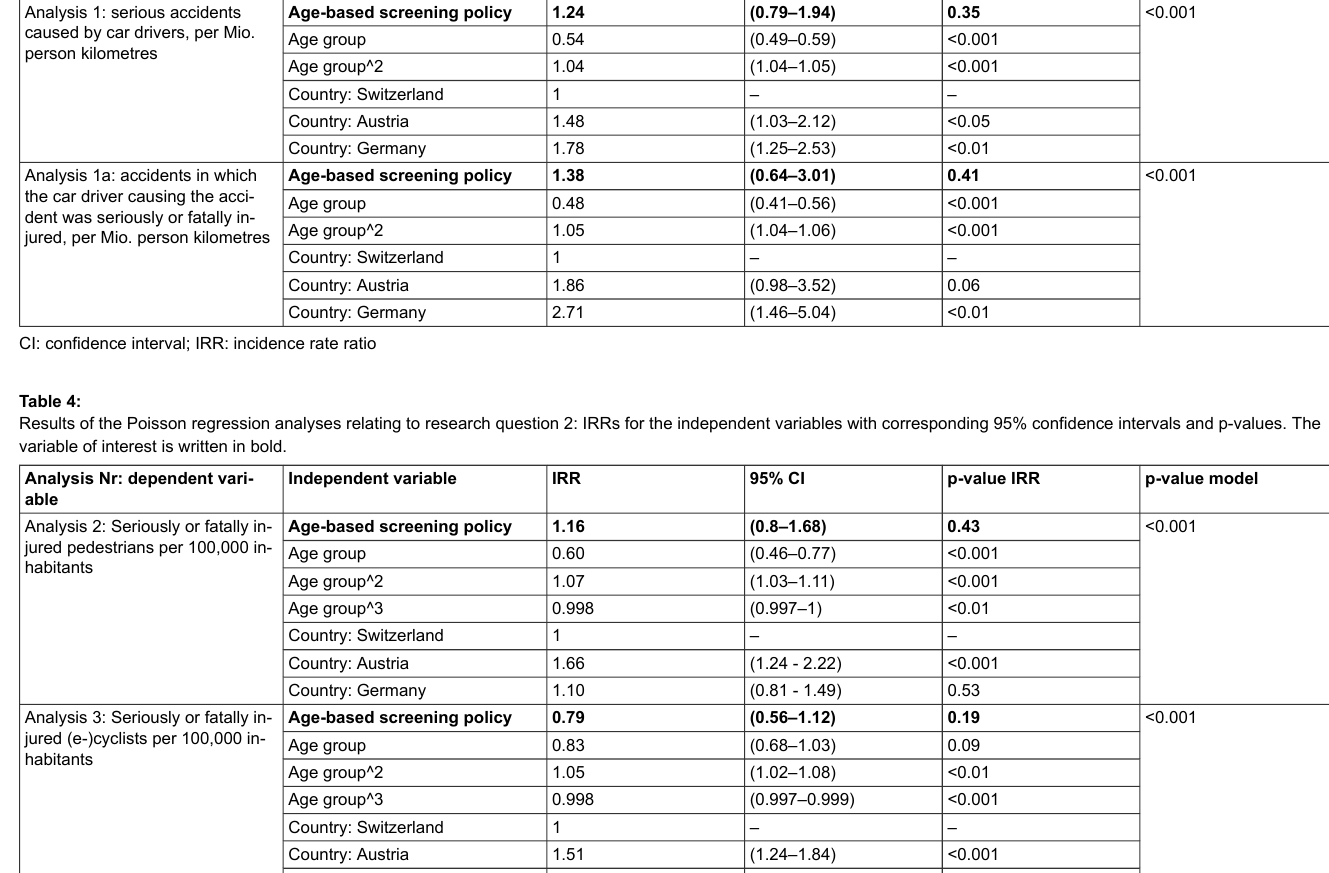
Table 3: Results of the Poisson regression analyses related to research question 1: IRRs for the independent variables with corresponding 95% confidence intervals and p-values. The variable of interest is written in bold. Analysis Nr: dependent vari- able